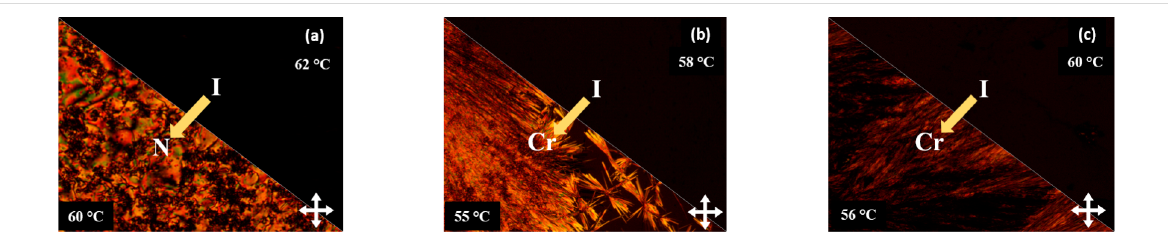
Figure 6: POM images of the supramolecular assemblies NO 2 -C 10 ∙∙∙ F 3 Az (a), NO 2 -C 10 ∙∙∙ F 2 Az (b) and NO 2 -C 10 ∙∙∙ F 2 ’Az (c) showing the phase transi- tion upon cooling from the isotropic melt (I) to the nematic (N) or crystalline phase (Cr).